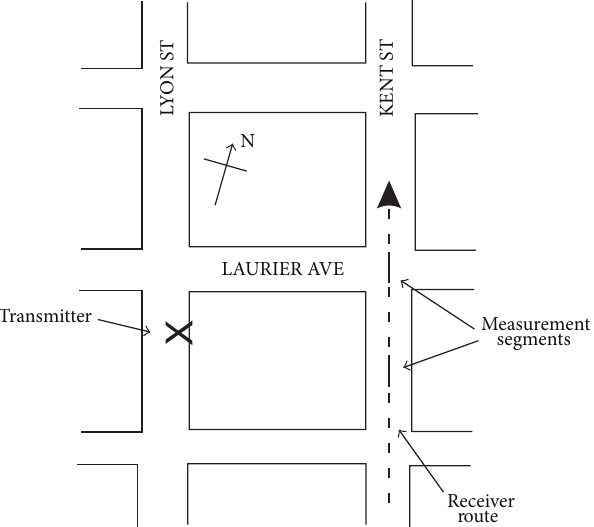
Figure 1: Location of measurement segments in downtown Ottawa,